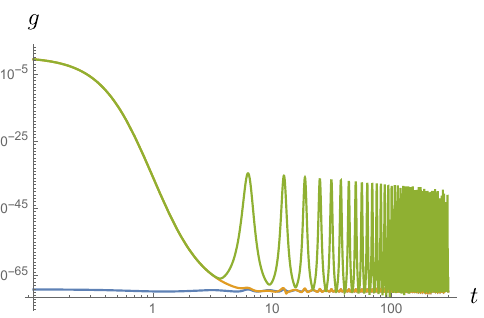
Figure 12 . The (normalized) spectral form factor for thermal AdS (blue), the BTZ black hole (yellow), and many saddles (green). The \plateau" decays at large times, showing information loss. We take c = 25 and (cid:12) =